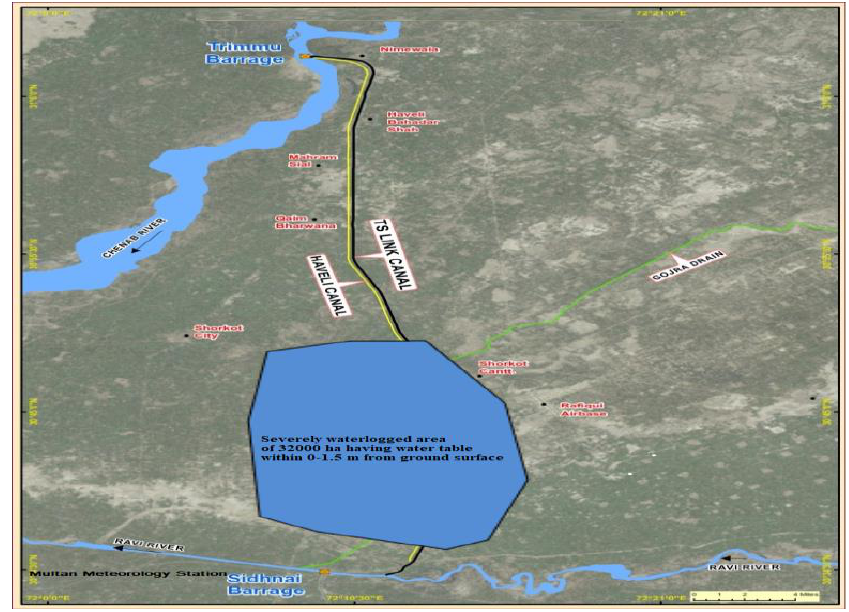
Figure 1. Location Map of Trimmu-Sidhnai Link Canal and Waterlogged Area (Shaded Blue). The seepage from unlined T-S link and damaged brick lining of Haveli canals, distributaries and minors, watercourses, deep percolation from irrigated agriculture fields, rainfall recharge and lateral groundwater inflow have caused waterlog in the study area. The situation further deteriorated, when 43 Salinity Control & Reclamation Project (SCARP) tube wells installed on the left bank of T-S link canal and right bank of Haveli main canal became inoperative along with poorly maintained surface drainage network. An area of 32,000 ha located along the tail reach of the T-S link canal (shaded blue in Figure 1) is severely waterlogged having groundwater table within 0–1.5 m from the ground surface